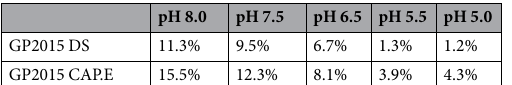
Table 1. The impact of pH on disulfide bridge shuffling. The table above shows the relative amount of peptide containing the incorrect disulfide bridge C 78 -C 88 in GP2015 drugs substance (DS) samples and GP2015 capture eluate process intermediates (CAP.E) when the digestion step of the non reducing peptide map was carried out at different pH. Higher pH was found to results in high levels of C 78 -C 88 , while the level of internal peptide standard remained stable. These data suggest that increased pH promotes disulfide bridge shuffling and results in increased incorrect bridging. In contrast, performance of the non reducing peptide map at pH 6.0 or below resulted in stable low levels of C 78 -C 88 peptide suggesting a repression of